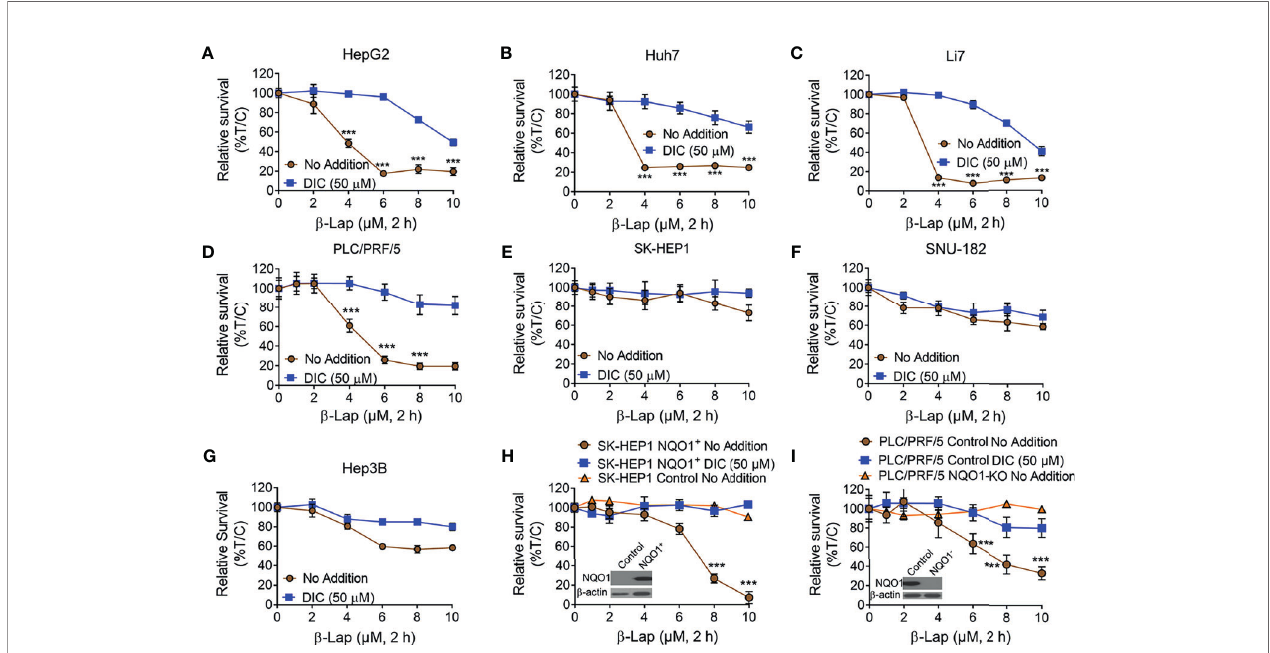
FIGURE 3 | The cytotoxicity of b -Lapachone in hepatocellular carcinoma cells is NQO1-dependent. (A – F) HCC cells (HepG2 (A) , Huh7 (B) , Li7 (C) , PLC/PRF/5 (D) , SK-HEP1 (E) , SNU-182 (F) , and Hep3B (G) , were exposed to b -lap (0-10 µM), ± dicoumarol (DIC, 50 µM) for 2 h, and then relative survival was assessed. (H, I) NQO1-overexpressing SK-HEP1 cells (H) and stable NQO1 knockout PLC/PRF/5 cells (I) were treated as in (A) , and then cell viability was assessed. All error bars are means ± SDs. *** p < 0.001 (t tests). No addition, DMSO alone; DIC, dicoumarol; b -lap, b -Lapachone. Inset, NQO1 expression in NQO1-overexpressing SK- HEP1 and NQO1 knockout PLC/PRF/5 cells was con fi rmed by western blotting. %T/C, the mean of